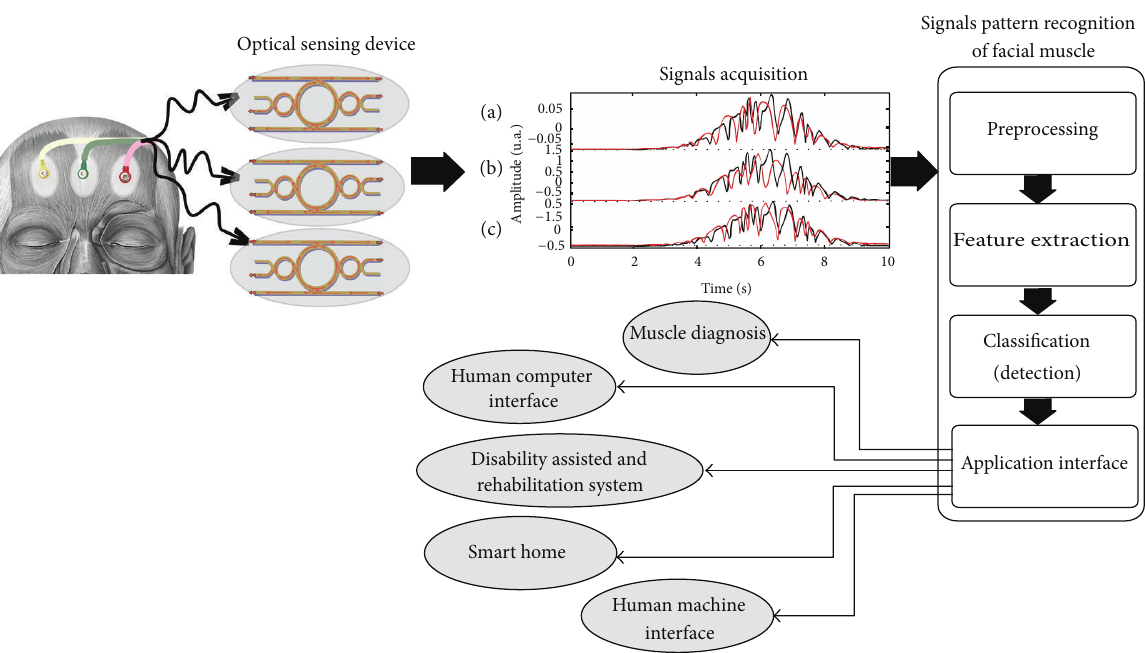
Figure 3: The proposed design system: three probes are connected to human forehead, in which the received signals (a), (b), and (c) are the interference fringes, which can be introduced and detected if the form of optical interference fringe